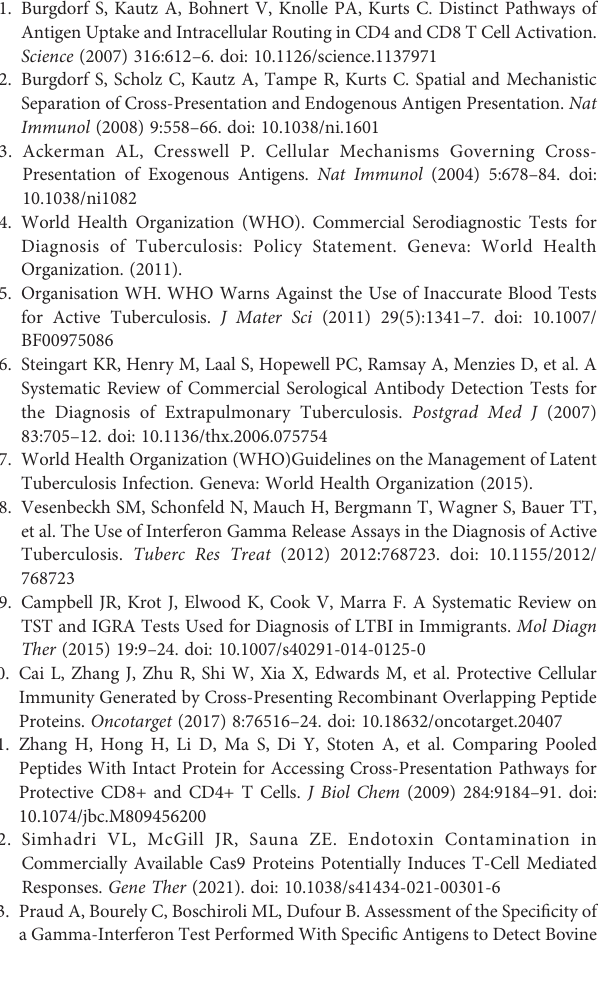
Supplementary Figure 1 | ELISPOT responses to ROP-TB spiked with different concentrations of endotoxin in two Mtb- infected patients and two healthy donors. Negative control: culture medium (R10); stimulant: ROP-TB (5 m g/well); endotoxin with 3 different doses (33, 6.6 and 3.3 EU/mL); Positive control: PHA (5 m